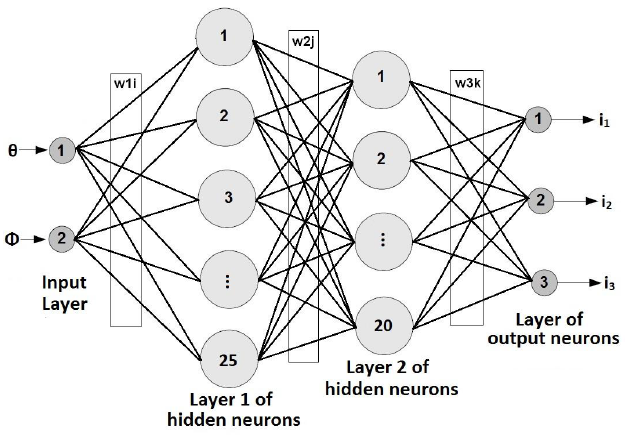
Figure 6. The chosen topology of the MLP